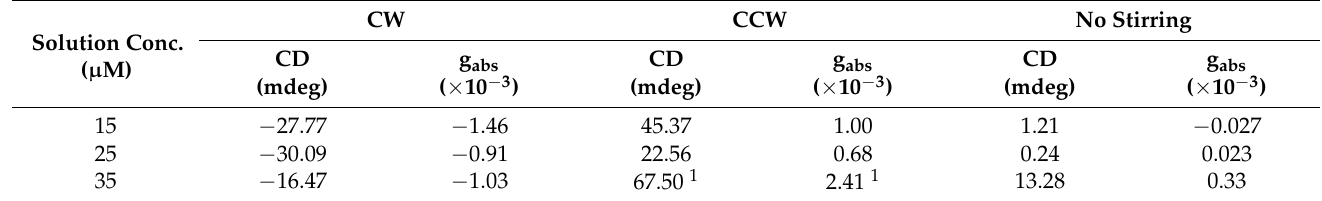
Table 2. Solution studies: the CD and dissymmetry factor dependence as function of stirring direction and solution concentration measured on MMP at 15 µ M, 25 µ M and 35 µ M in Milli-Q water (pH 7.12, 18.2 Ω cm − 1 ) at the wavelength of maximum ellipticity, θ max , average of 4 scans, recorded at 24 ◦